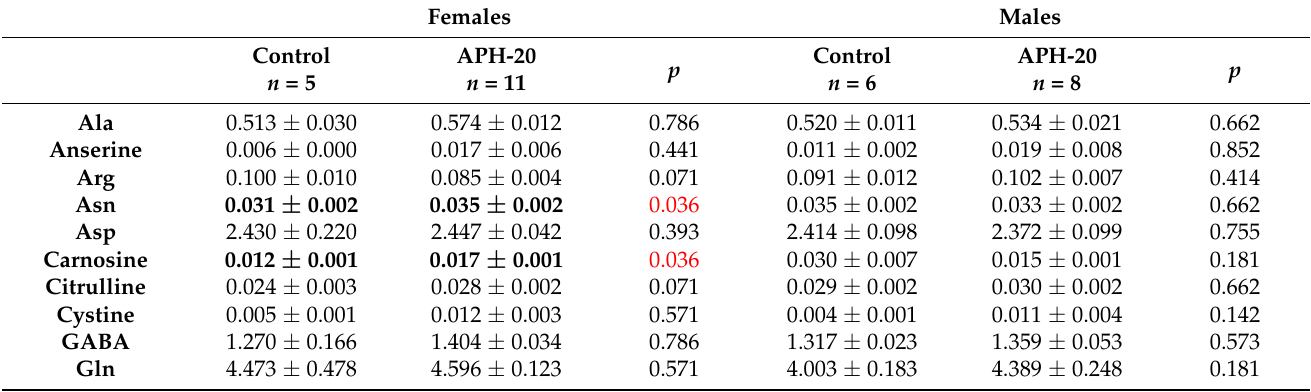
Table 1. Influence of acute prenatal hypoxia on the 20th day of gestation (APH-20) on the levels of amino acids and dipeptides in cerebral cortex of the rat offspring. The proteinogenic amino acids are abbreviated by the standard three-letter code. GABA—gamma-aminobutyric acid. Levels of the indicated compounds are presented in µ mol per g of the tissue fresh weight as the mean ± SEM. Significance of the differences between the two groups (control and APH-20-exposed) is characterized by the p -values according to the Mann–Whitney U test, shown in the table. Significantly different ( p < 0.05) levels of the compounds are shown in bold, with the corresponding p -values colored in red. n —The number of rats in each